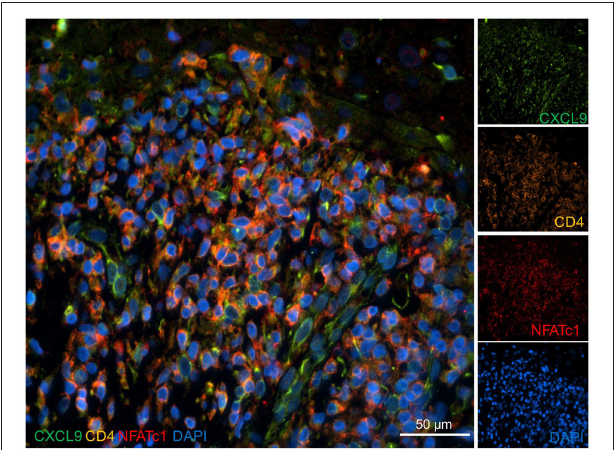
FIGURE 6 | Expression of CXCL9 in the skin of a lichen planus patient. Skin sections were stained with Abs directed against CXCL9, NFATc1, and CD4 and co-stained with DAPI as indicated. Immunofluorescence microscopy, 40x